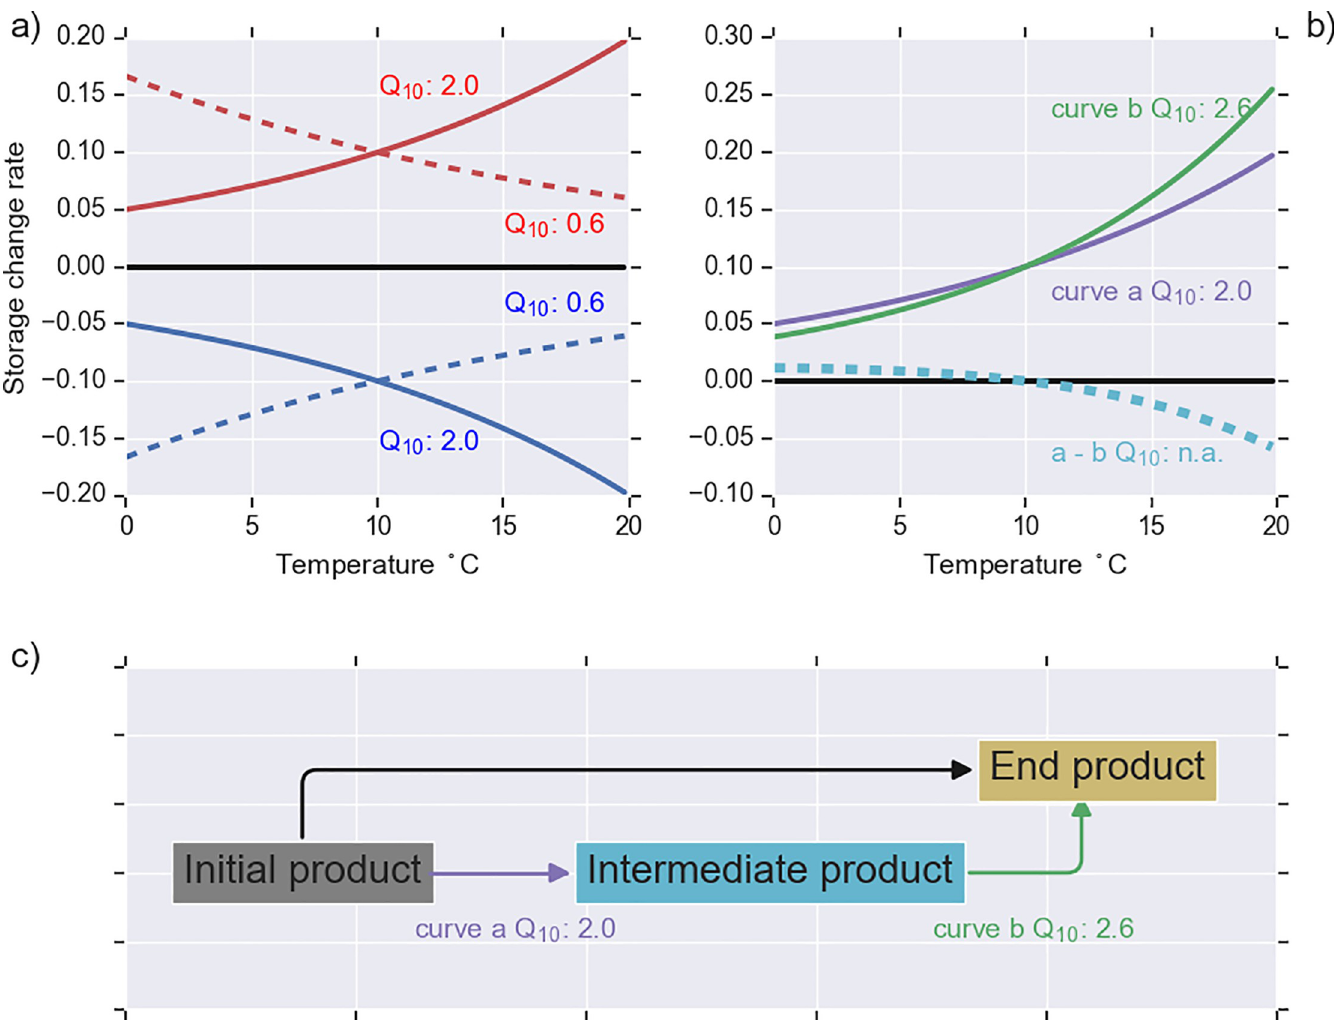
Fig 7. Schematic presentation of different temperature sensitivity patterns. In panel a) the solid red line refers to the positive upwards pattern (k ref > 0 and Q 10 > 1; Eq 3), the dashed red line refers to the positive downwards pattern (k ref > 0 and 0 < Q 10 < 1), the solid blue line is the negative downwards pattern (k ref < 0, Q 10 > 1), and the dashed blue line is the negative upwards pattern (k ref < 0, 0 < Q 10 < 1). The mixed temperature response (panel b, dashed light blue line) occurs for change rates typical for intermediate decomposition products (panel c) when the temperature sensitivity of the incoming and outgoing fluxes are different (panels b and c).